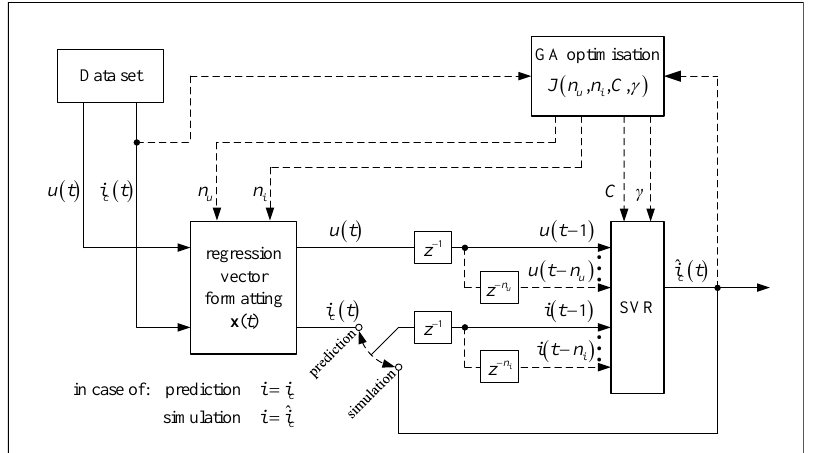
Figure 5. Diagram of the optimal parameter value selection